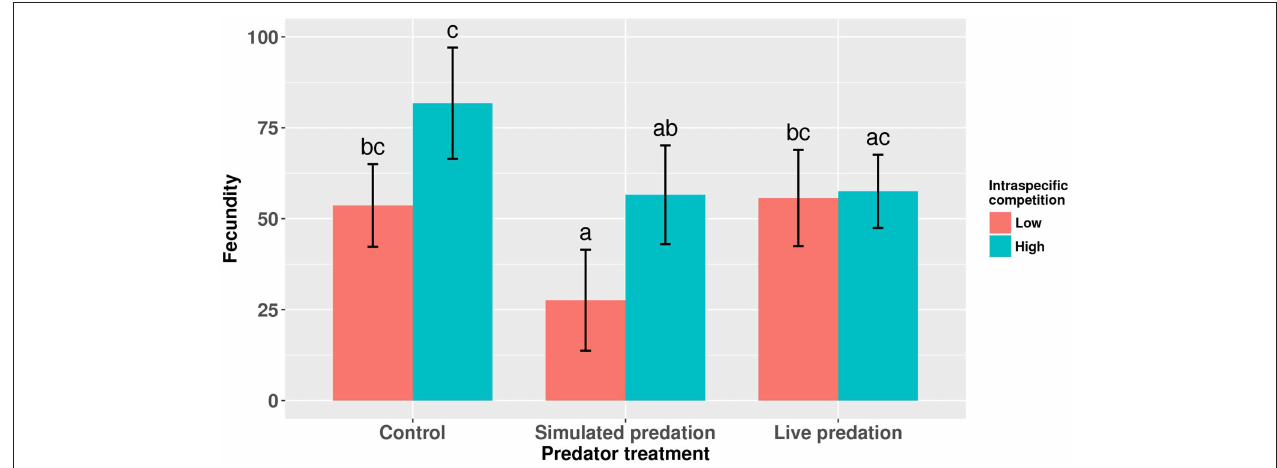
FIGURE 6 | Number of eggs produced by adult female Aedes aegypti in first gonotrophic cycle. Values plotted are least squares means ± 95% CI. Data were statistically tested using ANOVA and significant effects are described in Table 6 . Treatment means associated with the same letters are not significantly different in pairwise comparisons using Bonferroni adjustment for multiple tests.